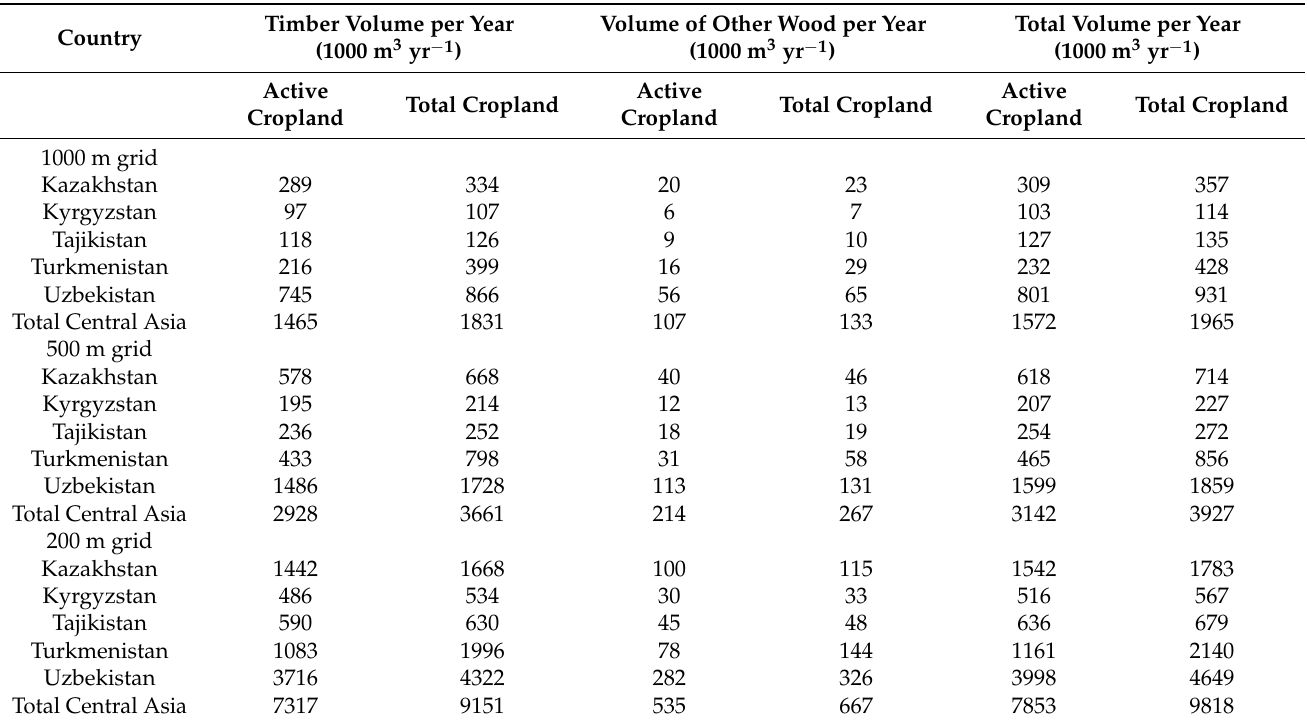
Table 6. Timber volume per year, volume of other wood per year, and total wood volume per year under 1000 m, 500 m, 200 m grids by country (million m 3 ), current adoption (26% of the potential tree windbreaks